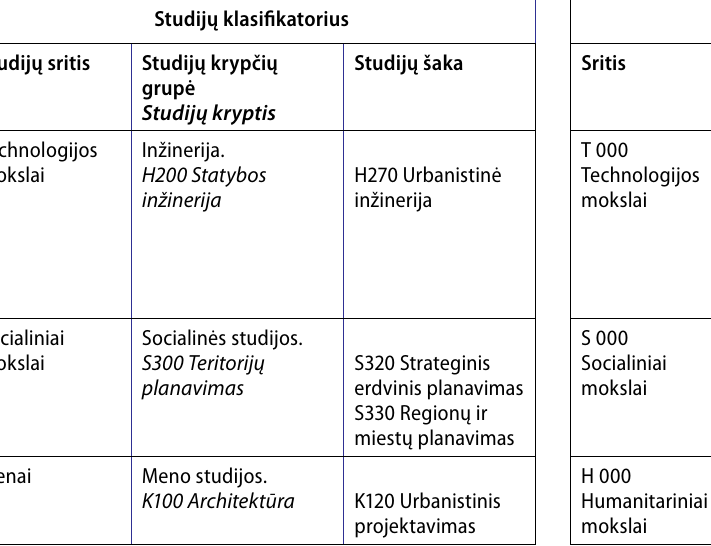
Table 1. Comparison of the position of art and science of urban design in the classifications of higher education and research Studijų